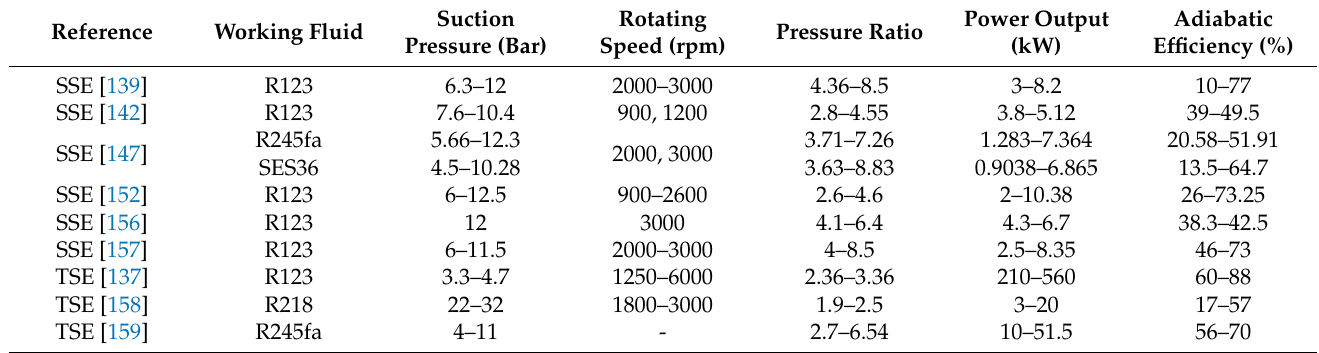
Table 3. Reported performance of screw expanders used in ORC systems in experimental